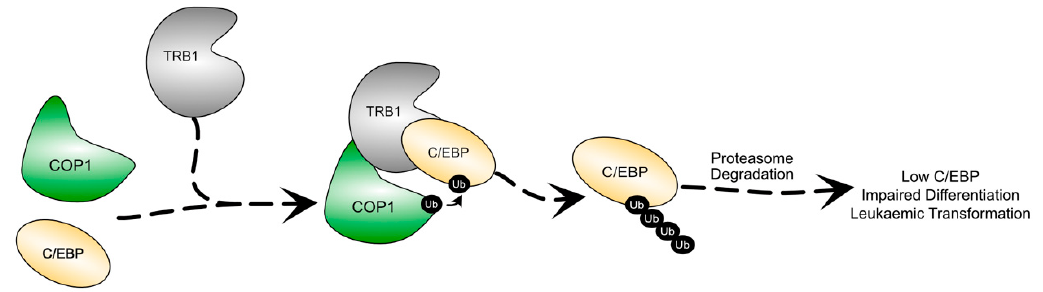
Figure 3. Schematic illustration of the degradation of C/EBP proteins by TRIB1. TRIB1 scaffolds the interaction between COP1 and C/EBP, resulting in the ubiquitination and proteasomal degradation of C/EBP. Lowered C/EBP levels are associated with impaired haematopoietic differentiation and leukaemic transformation.